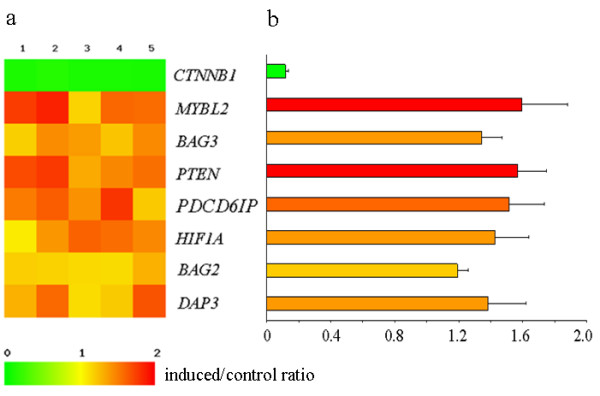
Microarray cluster analysis demonstrating differentially expressed genes in HeLaT-β-catenin-RNAi cells treated with DOX. After 3 days of treatment, 50–100 μg of DNA-free total RNA from control or induced cells was reverse transcribed and labeled with Cy3 or Cy5 and then hybridized to the oligonucleotide microarray containing 1384 apoptosis-related genes. Microarray experiments were performed comparing induced vs. control cells. Shown here are the intensity ratios of 5 separate experiments (a) or means ± S.D (b). The color bar represents the intensity ratio of induced vs. control cells.